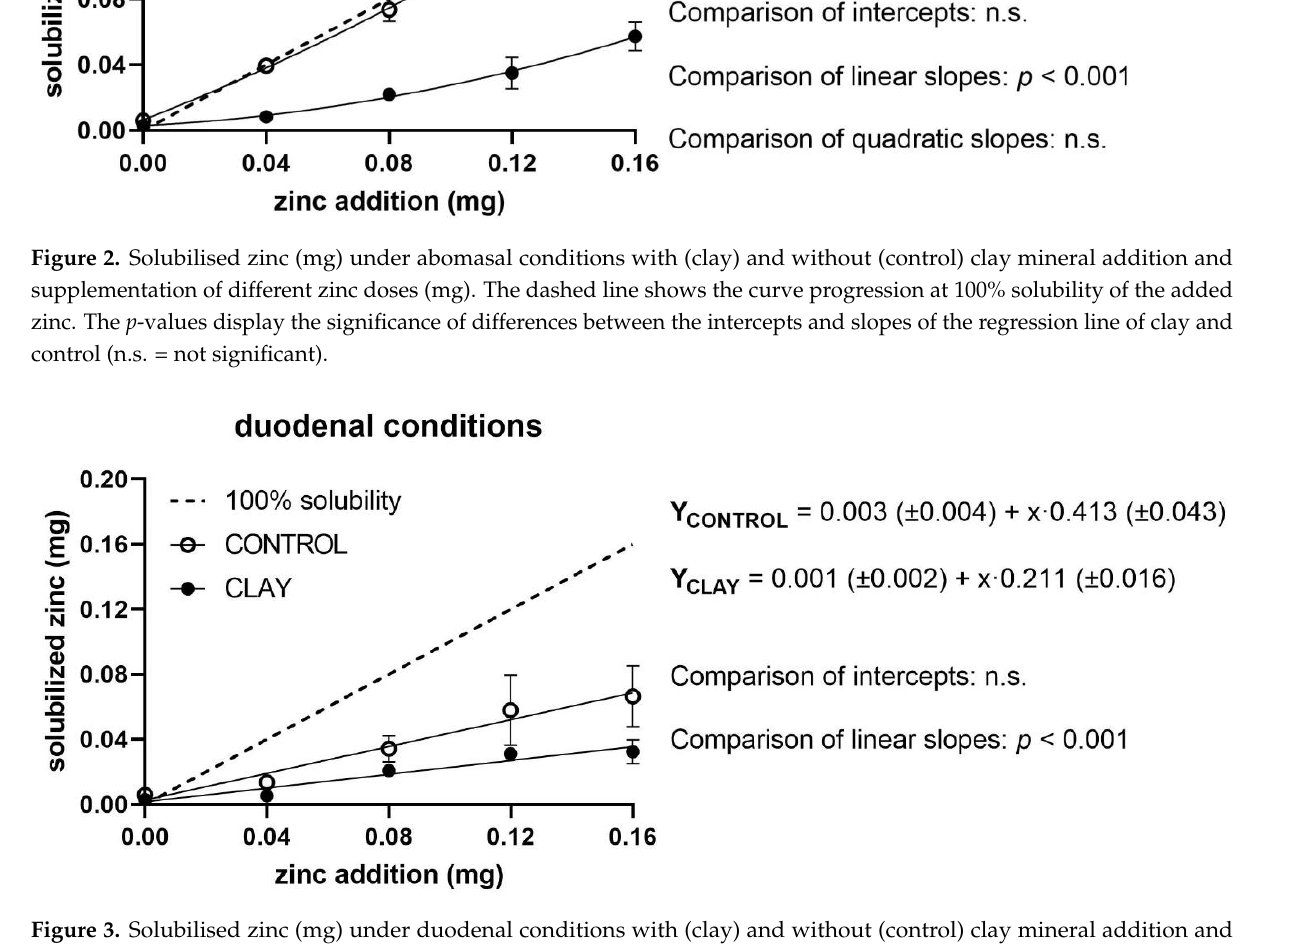
Figure 3. Solubilised zinc (mg) under duodenal conditions with (clay) and without (control) clay mineral addition and supplementation of different zinc doses (mg). The dashed line shows the curve progression at 100% solubility of the added zinc. The p -values display the significance of differences between the intercepts and slopes of the regression line of clay and control (n.s. = not significant).